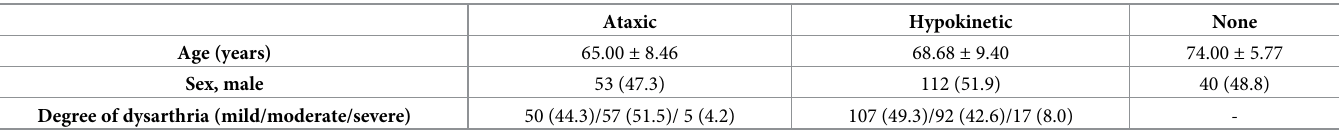
Table 2. Demographics and clinical characteristics.